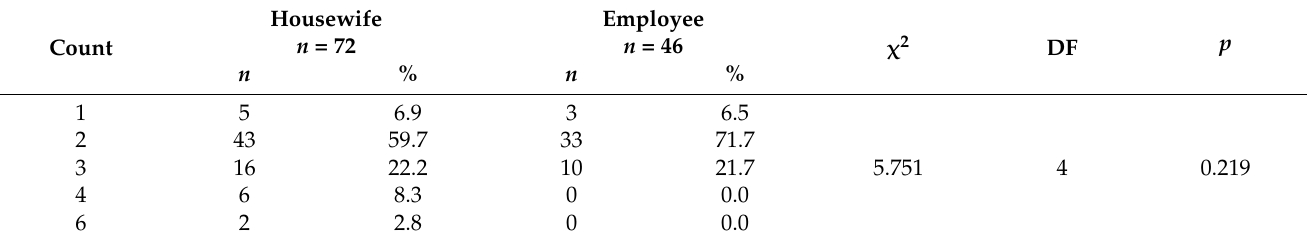
Table 6. Mother’s responses to the question: “How many times did you remove the appliance from your baby’s mouth for cleaning?” in association with working status.